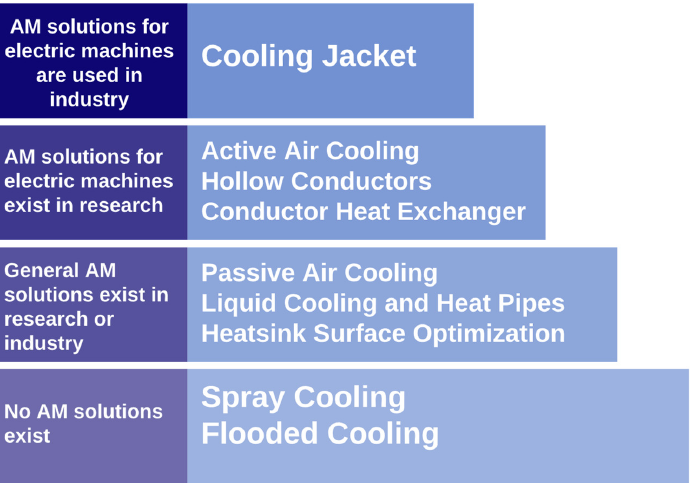
Figure 19. The maturity level of different AM thermal management solutions in the context of cooling electrical machines.